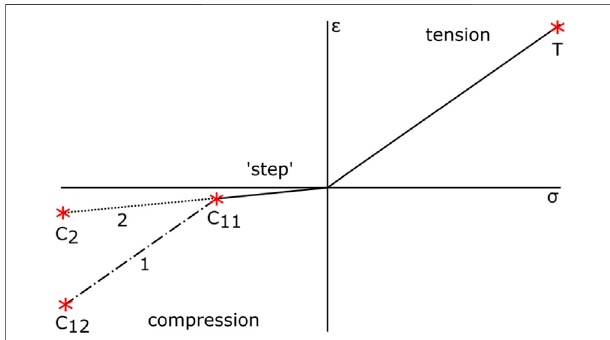
FIGURE 3 | Schematic of the tension-compression nonlinearity in fi ber direction to model the bending behavior. The highlighted points T, C 11 , C 12 , and C 2 indicate the points speci fi ed in the input fi